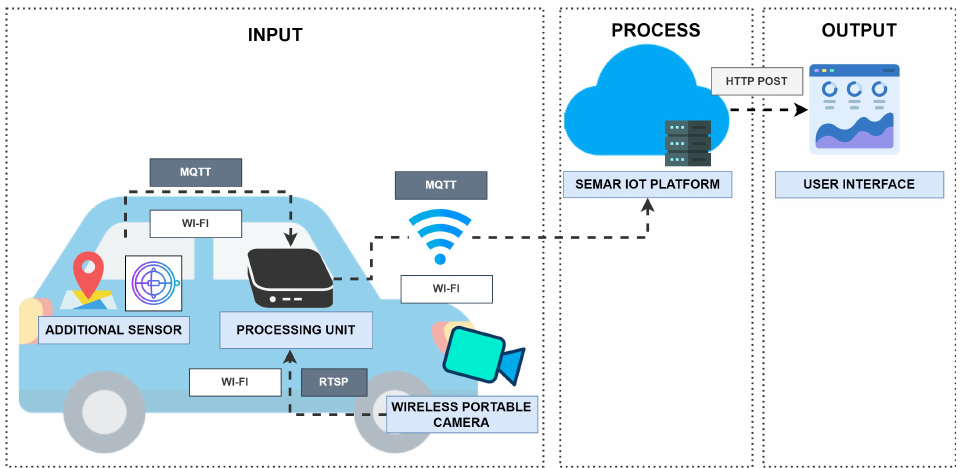
Figure 11. System overview of road condition monitoring system .